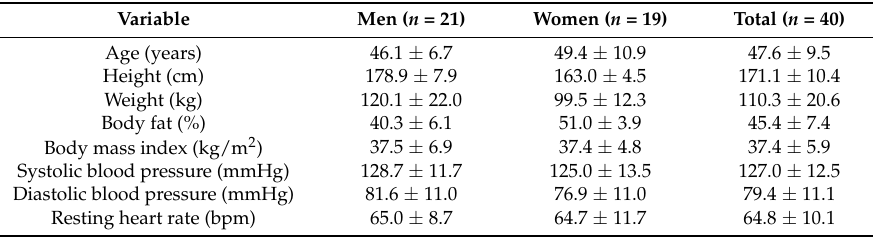
Table 3. Baseline (Week 0) characteristics of study participants for WL (Phase 1).